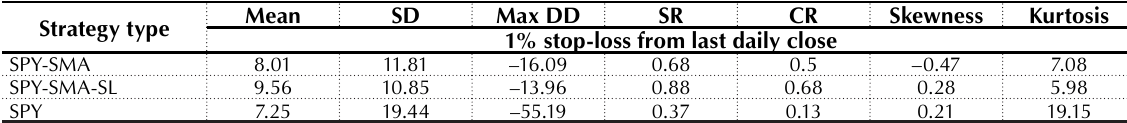
Table 4. Summary statistics of SPY-SMA with daily stop loss January 1, 2004 – October 13, 2015 Strategy